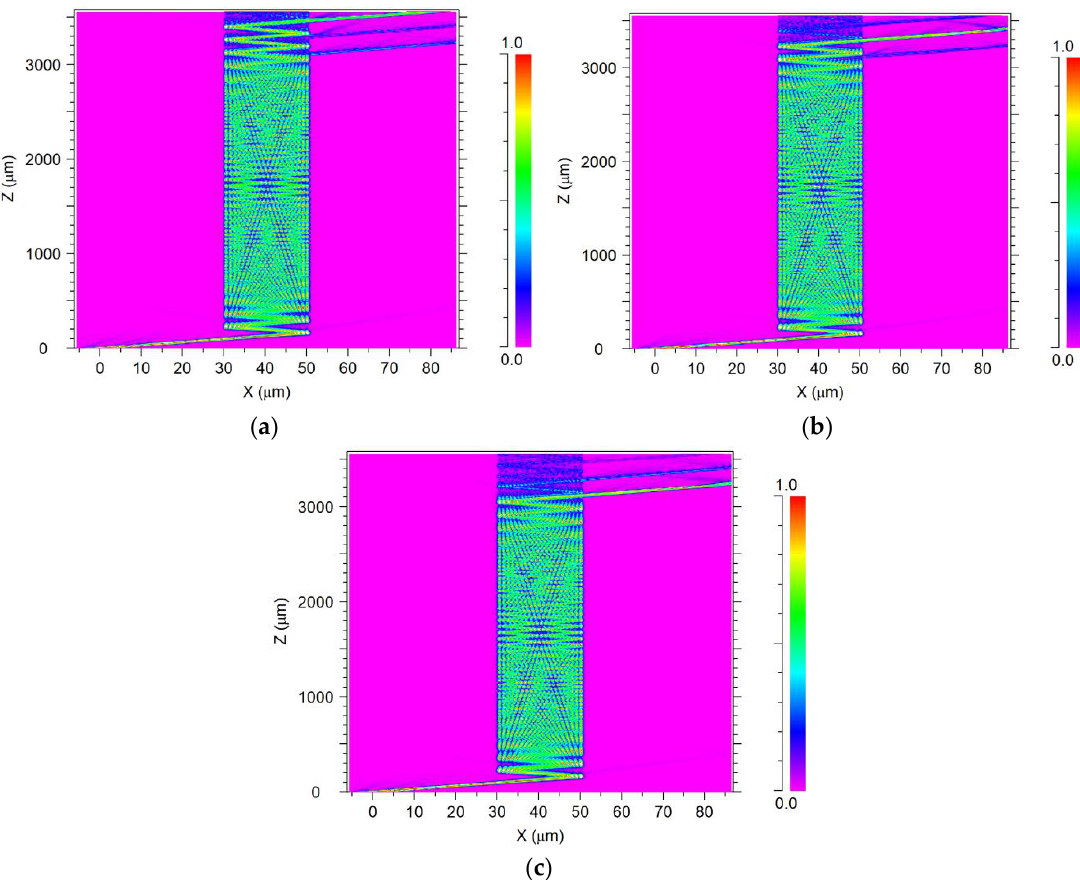
Figure 8. Light intensity profile of the AMMI 1 × 3 demultiplexer at the x–z plane. ( a ) 1.53 μm, ( b ) 1.5475 μm, and ( c ) 1.565 μm.